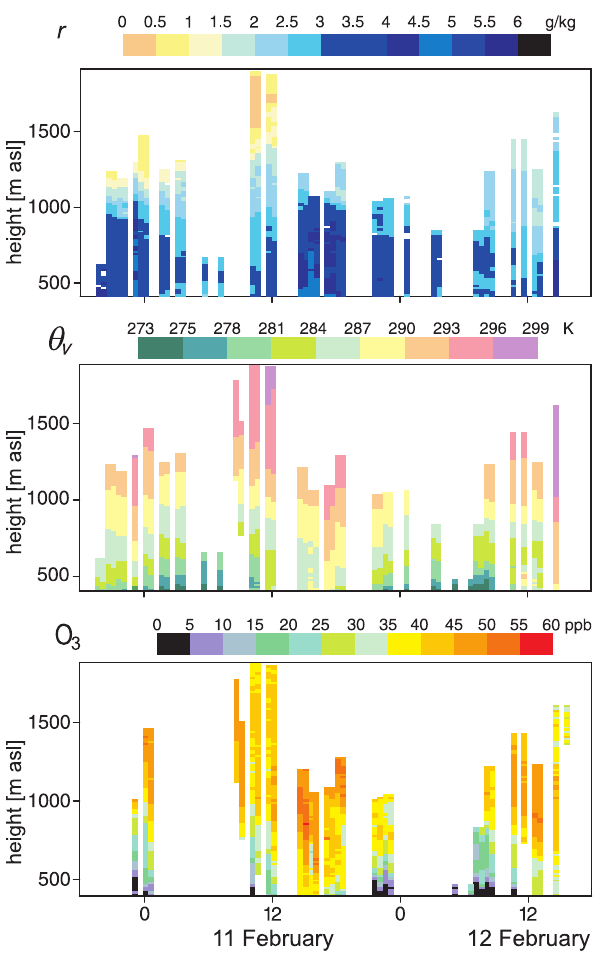
Fig. 3a. Time-height cross sections of virtual potential temperature, water vapour mixing ratio, and ozone concentrations as measured with tethered balloon during the February 1998 campaign. Every ascent or descent was attributed to a fixed half-hour interval.